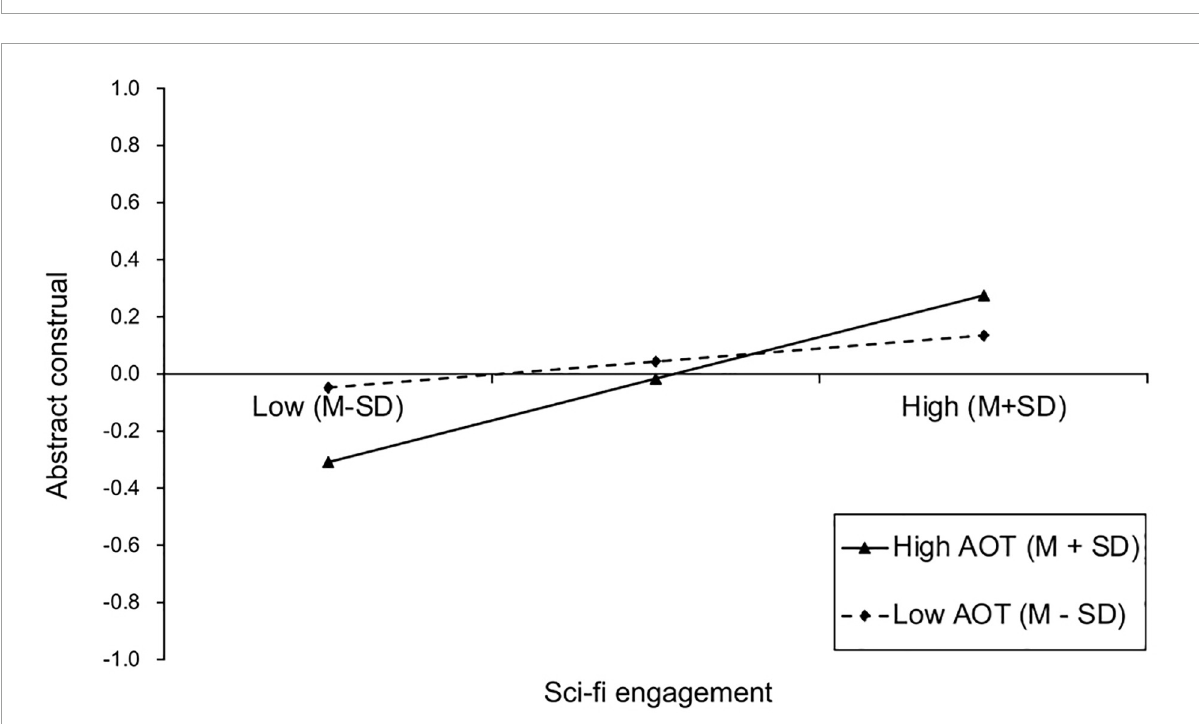
FIGURE4 Interaction effect of sci-fi engagement and AOT on abstract construal. AOT, Actively open-minded thinking; M, Mean; SD, Standard deviation.